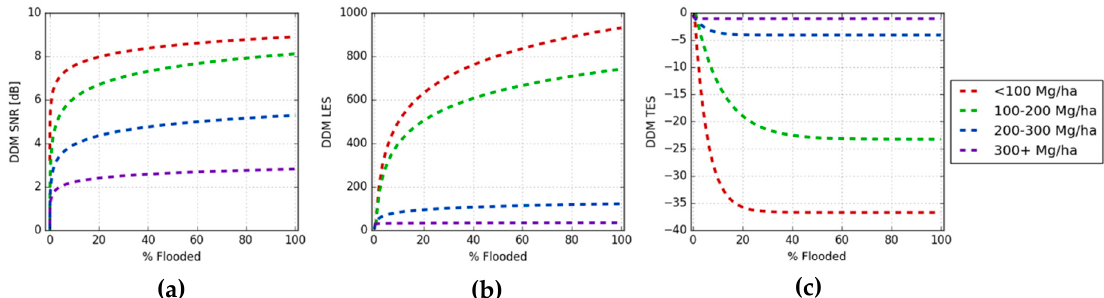
Figure 15. Relationship of footprint flooded area percentage (all flooded classes considered) vs. DDM ( a ) SNR; ( b ) LES; ( c ) TES. DDM observables are divided into four categories of GFW-AGB density (<100, 100–200, 200–300, and 300+ Mg ha − 1 ), with best-fit logarithmic curves shown in ( a , b ) and exponential fit used in ( c ).